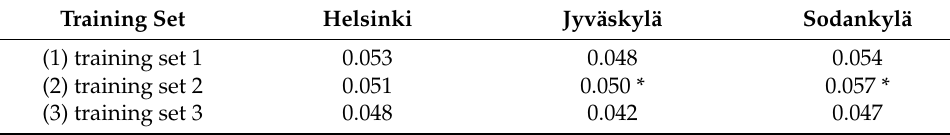
Table 4. NRMSE in the test set for different geographical locations.